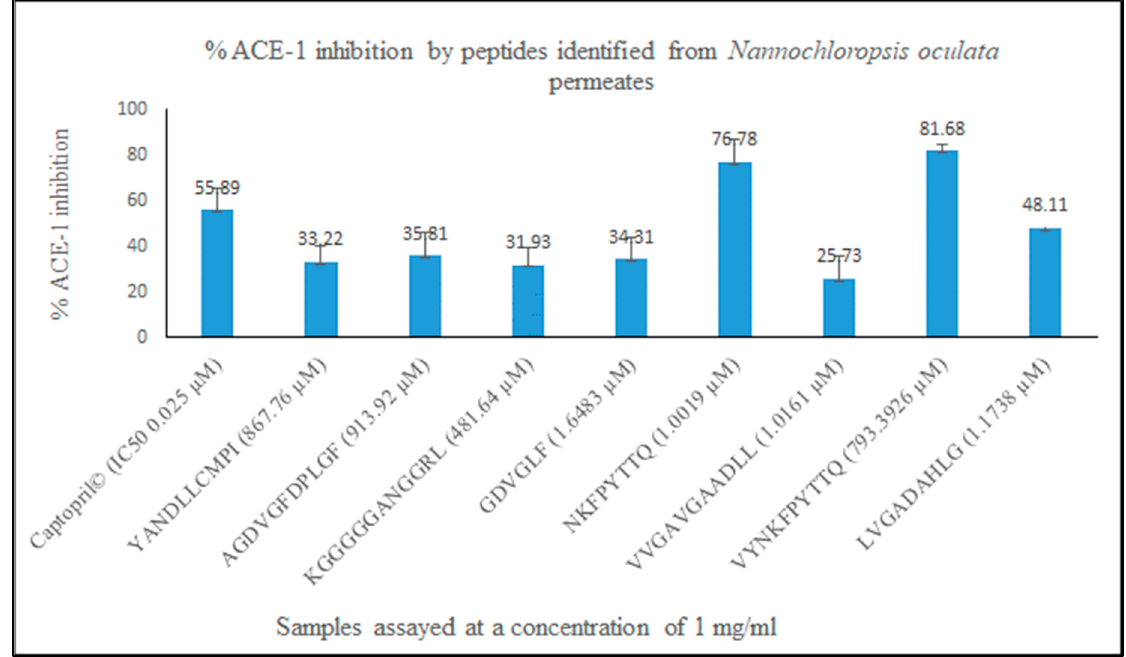
Figure 3. ACE-1 inhibitory activities of identified and synthesised peptides from Nannochloropsis oculata treated with xylanase.